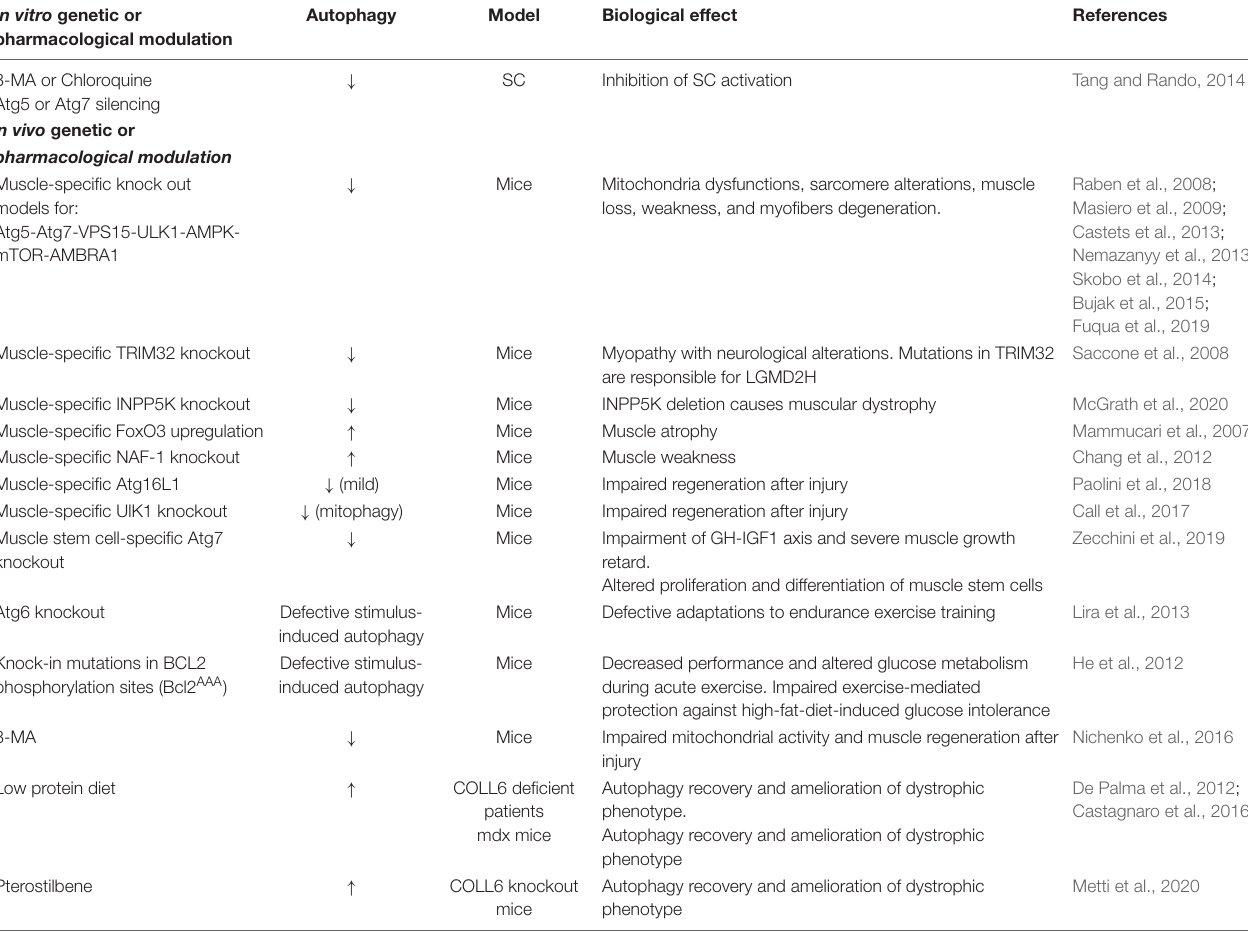
TABLE 2 | A summary of the current knowledge on the role of autophagy in the maintenance of muscle behavior and